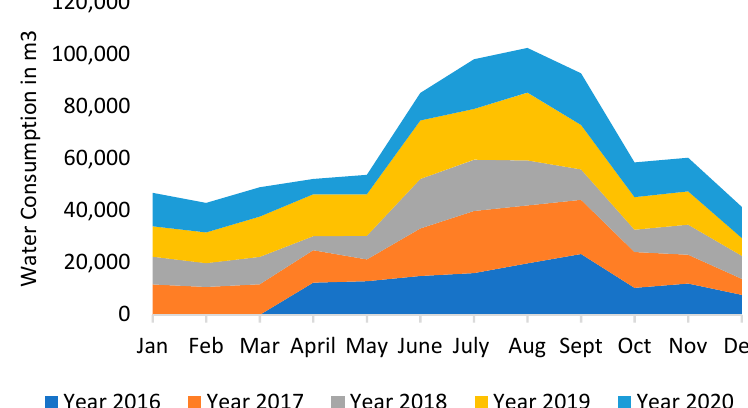
Figure 4. The trend of water consumption.